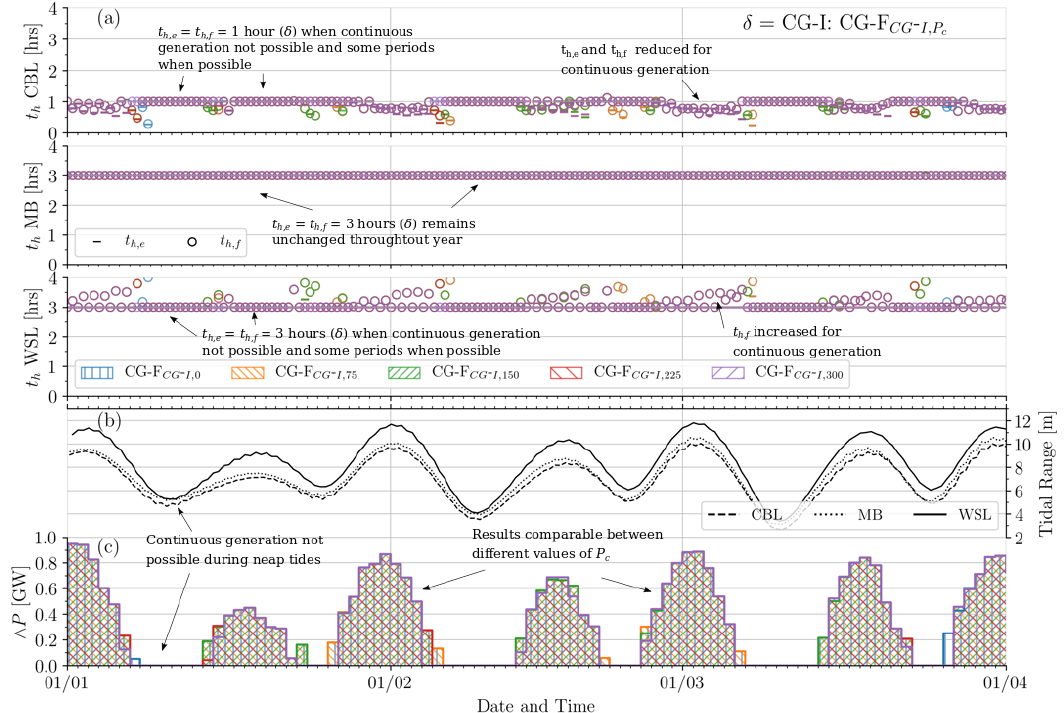
Figure 9. Temporal operation characteristics of the tidal power plant system in applying flexible controls to optimise towards continuous generation, with δ = CG-I, an inflexible baseload generation default (CG-I CG - I , P ). For all three power plants, ( a ) indicates holding periods t h , e and t h , f per tidal c cycle ( b ) the tidal range each cycle and ( c ) daily cumulative minimum power output ∧ P